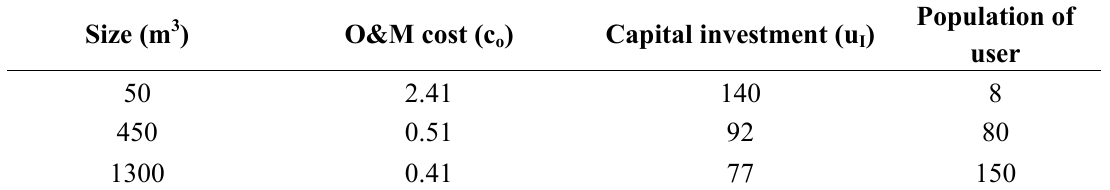
Table 2. The parameters for different sizes of rainwater systems (RMB/m 3 ).